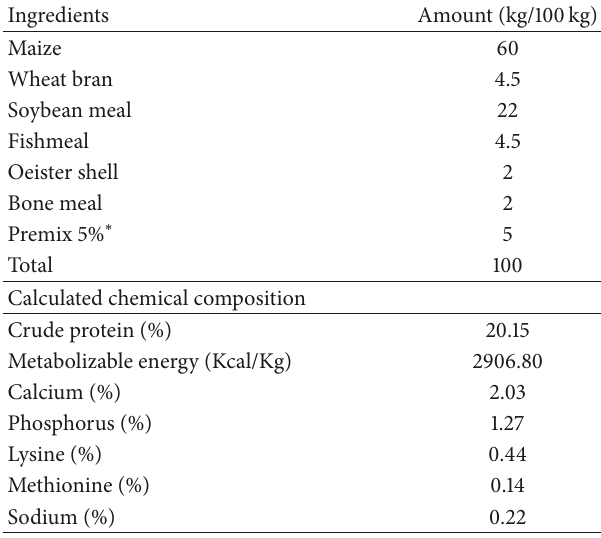
Table 1: Phytochemical constituents of ginger essential oil. Constituents